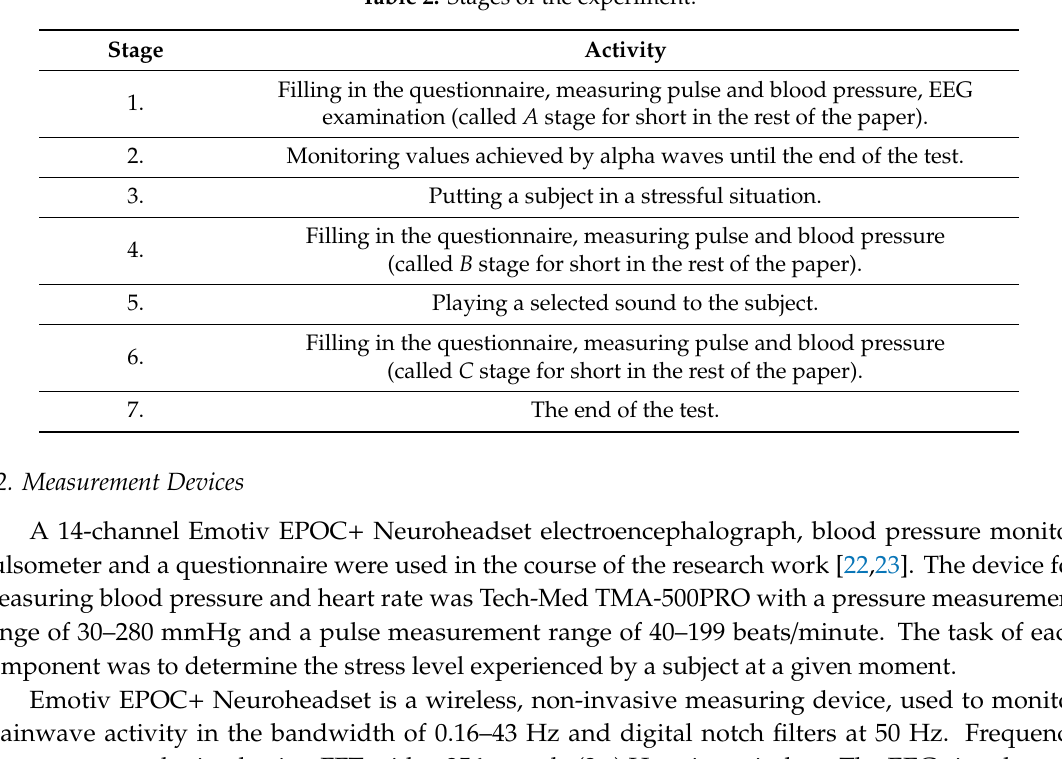
Table 2. Stages of the